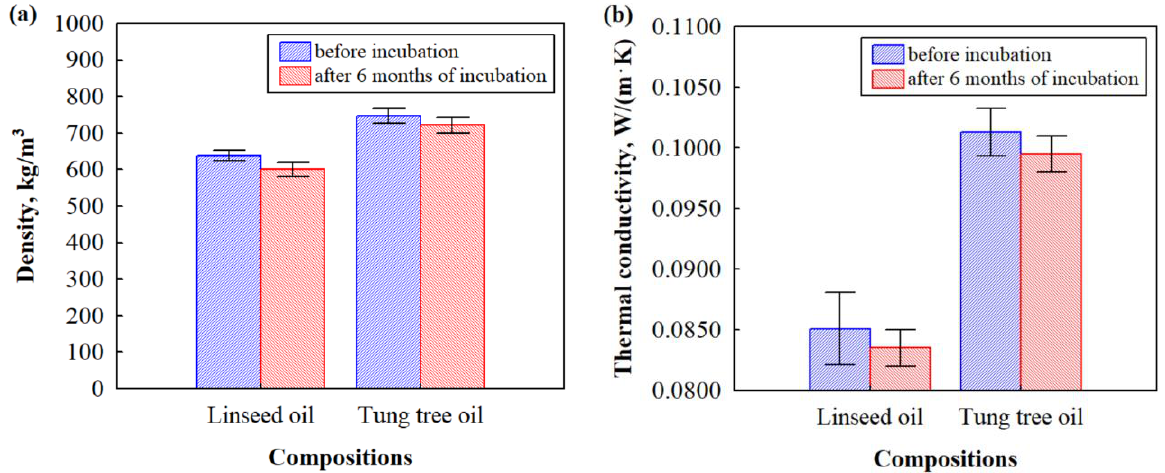
Figure 6. The impact of microorganisms on the selected properties of HS- and CS-based biocomposites impregnated with different oils before and after incubation for 6 months: ( a ) density; ( b ) thermal conductivity.